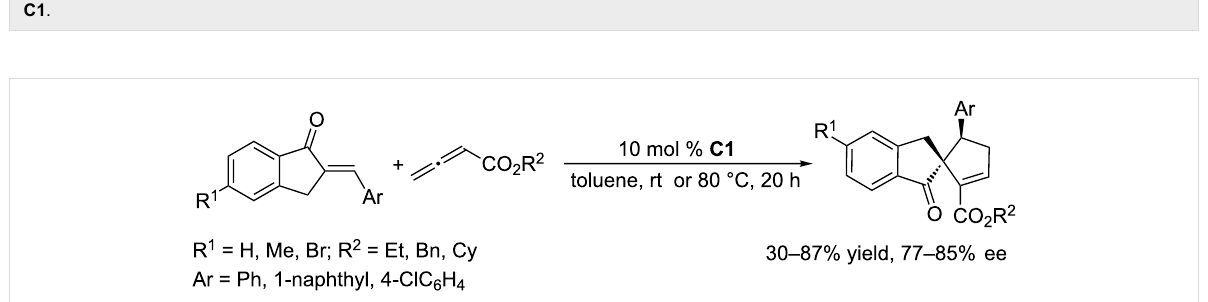
Scheme 10: Asymmetric [3 + 2] annulations of exocyclic enones with allenoates, catalyzed by the ferrocene-modified phosphine C1 .